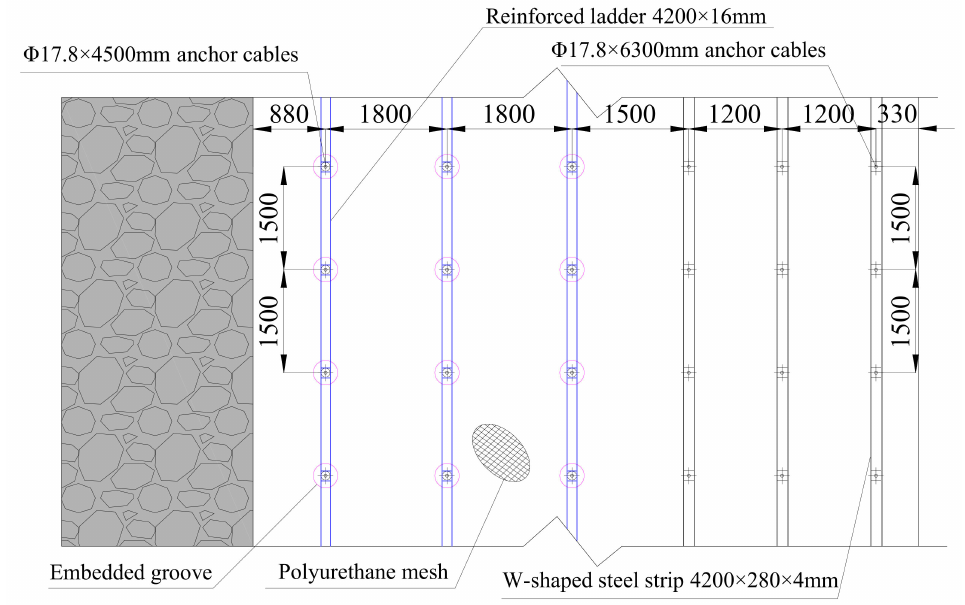
Figure 25. Top view of stopping space